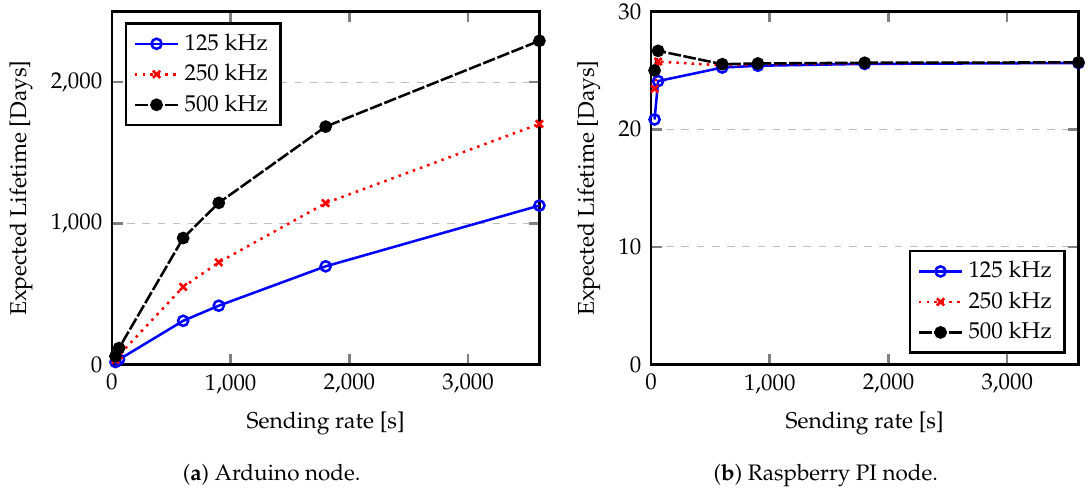
Figure 15. Expected lifetime according to the sending